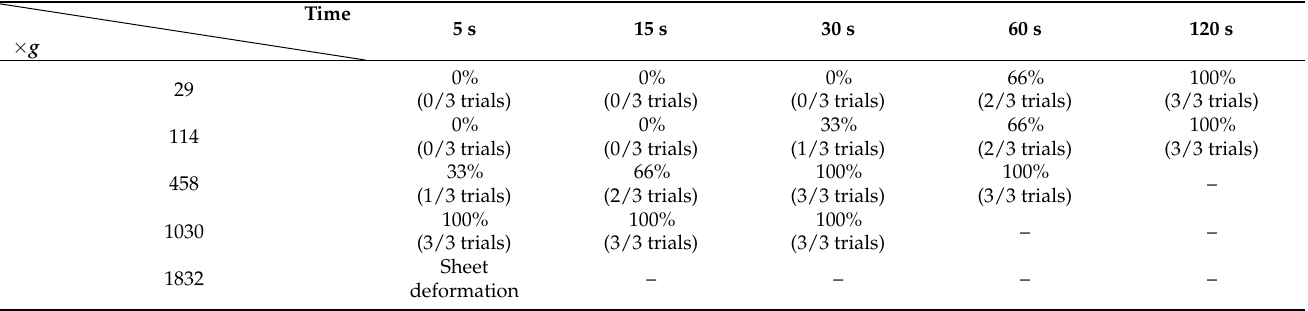
Table 1. Single layer cell sheet attachment rate following medium addition and mechanical rotation